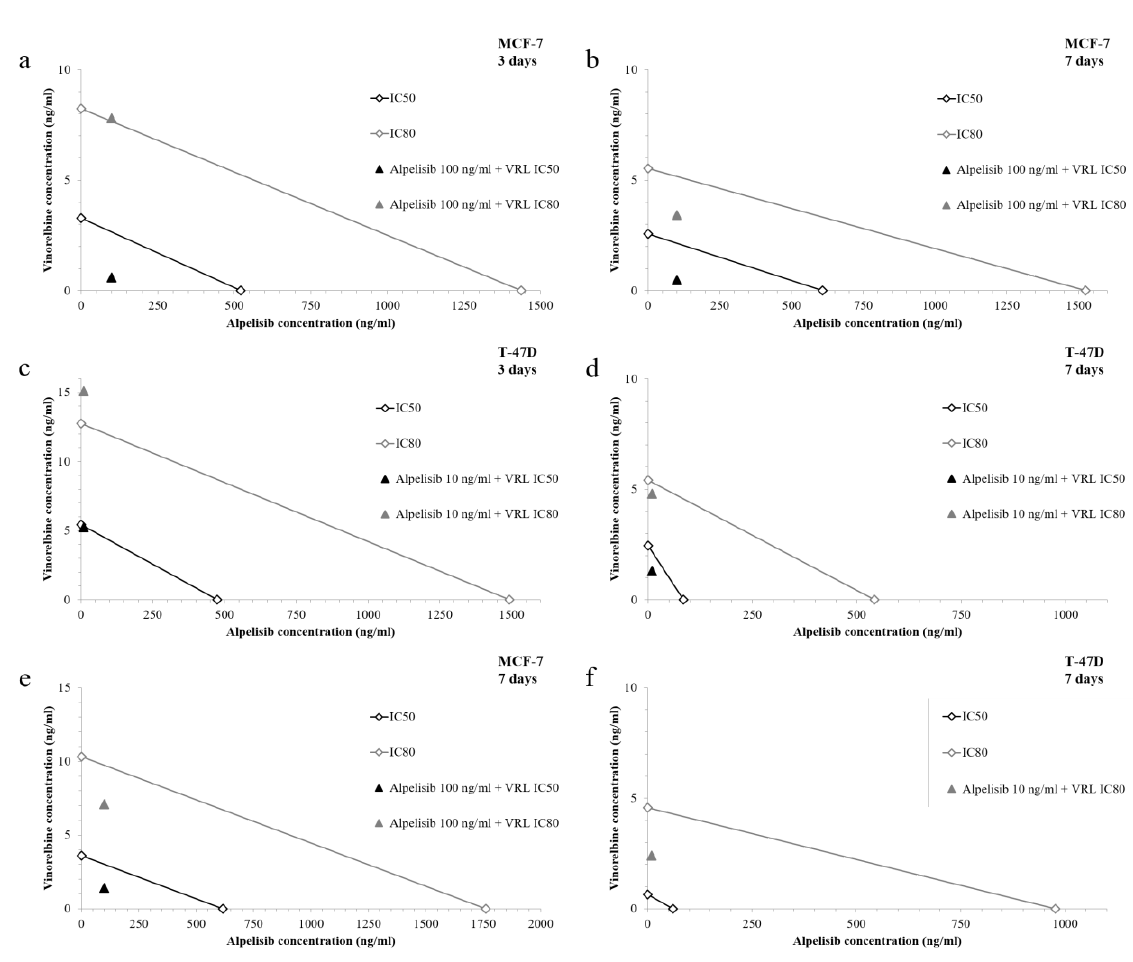
Figure 5: Combination index-isobologram for cell viability of the MCF-7 ( a , b ) and T-47D ( c , d ) cell line after 3 and 7 days of treatment and for cell proliferation of the MCF-7 ( e ) and T-47D ( f ) cell line after 7 days of treatment with low-dose vinorelbine plus alpelisib. The inhibitory concentrations (IC) 50 and IC 80 were calculated by interpolation and used as a reference. The combination index (CI) was calculated according to the formula shown in formula [1] and was interpreted as follows: CI<1, synergism; CI=1, additive effect, and CI>1, antagonism (range ± 5 %). The graphical presentation was performed as clas- sical isobologram with isoboles of the IC 50 or IC 80 and presentation of the corresponding CI values in relation to the corresponding isoboles within the